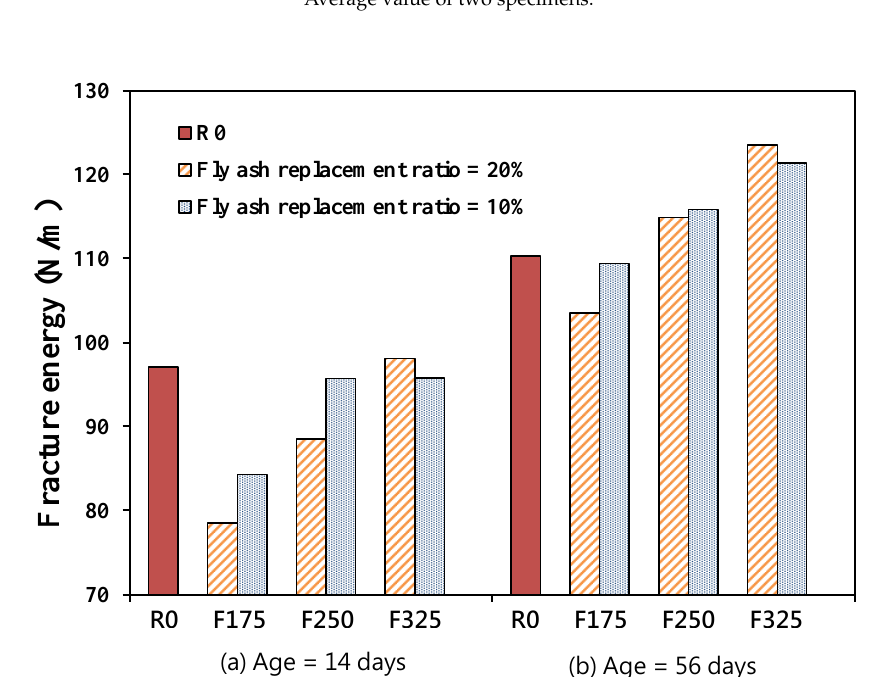
Figure 5. Fracture energy of concretes with various fineness levels and the replacement ratios of fly ash.